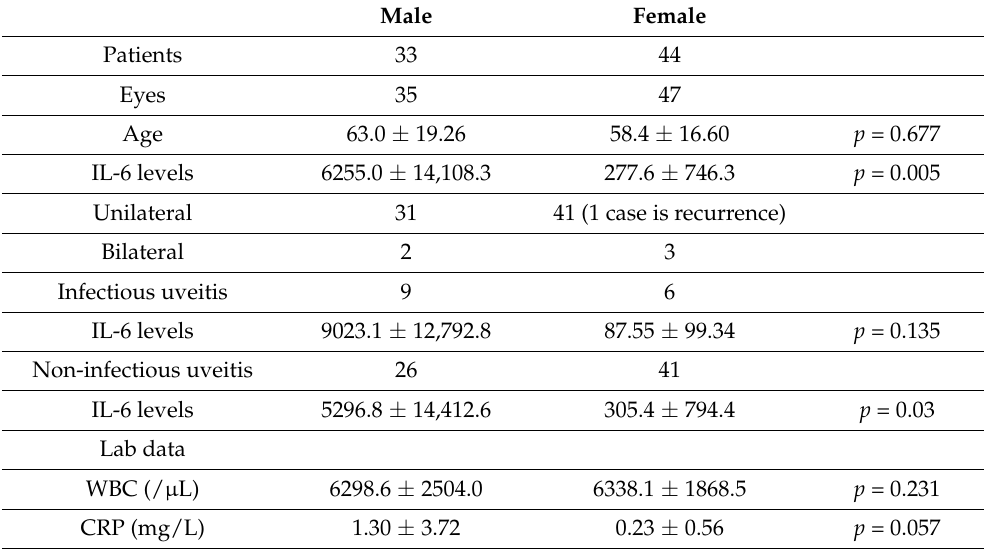
Table 1. Male and female patient characteristics.